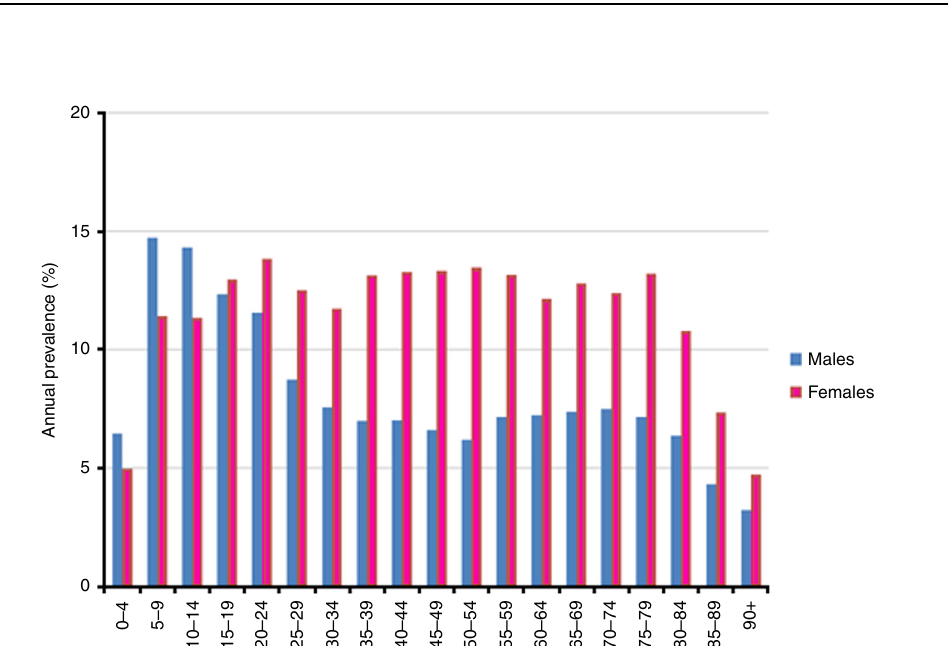
Incidence rates and 95% con fi dence intervals (CI) of anti-allergic drug prescriptions in individuals with acid inhibitor medication and with anti-hypertensive or lipid-modifying (C09/C10) drug prescriptions from data of the Austrian county Burgenland and rate ratios for an anti-allergic prescription in individuals with acid inhibitor medication relative to those with C09/C10 prescriptions. p values based on Wald chi-square test